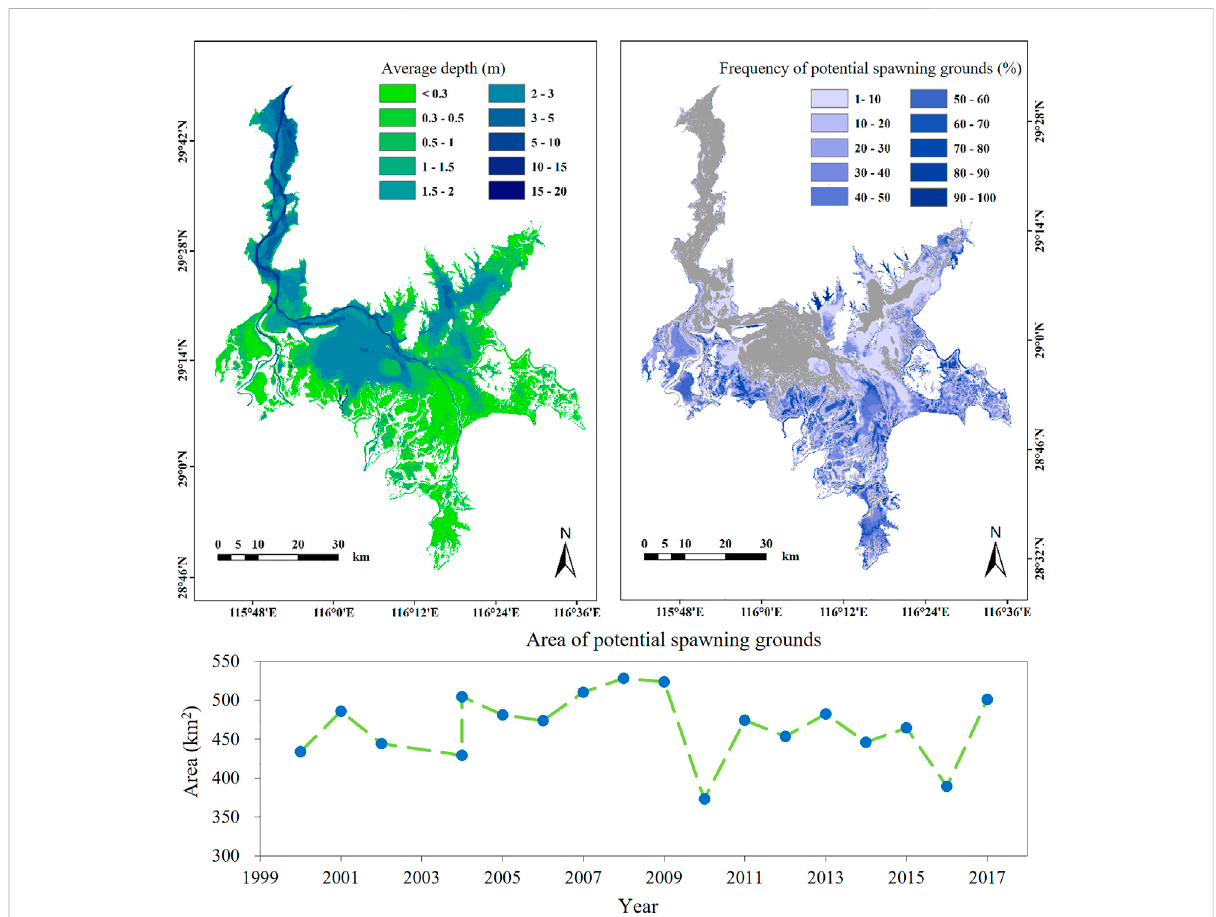
FIGURE 5 Area of potential spawning grounds estimated based on lake topography and monthly water area extent. The upper left panel represents the average depth of Poyang Lake during the study period. The upper right panel represents the distribution of the frequency of potential spawning grounds (%).The graypixelsinthebackground represent theplaces thatareunlikelyto bespawning grounds.Thebottompanel shows theareatime series of potential spawning